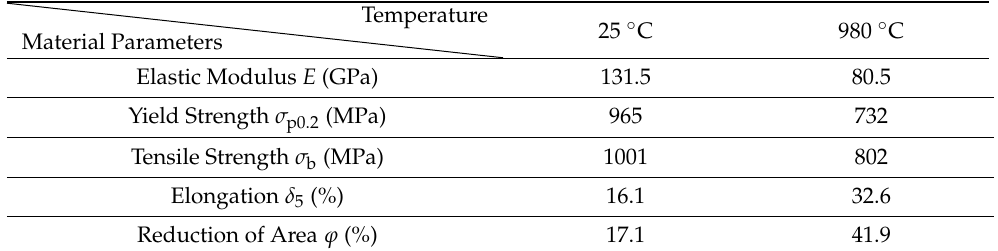
Table 1. Material properties of DD6 [001] alloy at 25 °C and 980 °C [23].